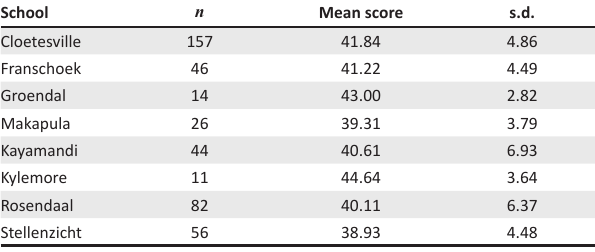
TABLE 1: Participant feedback on booklet